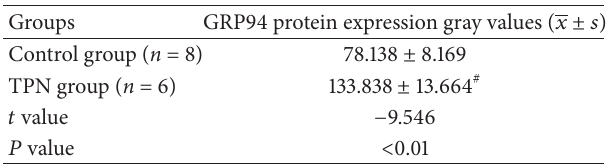
Table 4: Comparison of liver tissue GRP94 mRNA level gray values ( 𝑥 ± 𝑠 ). Groups GRP94 mRNA Control group ( n = 8) 0.614 ± 0.034 TPN group ( n = 6) 1.217 ± 0.112